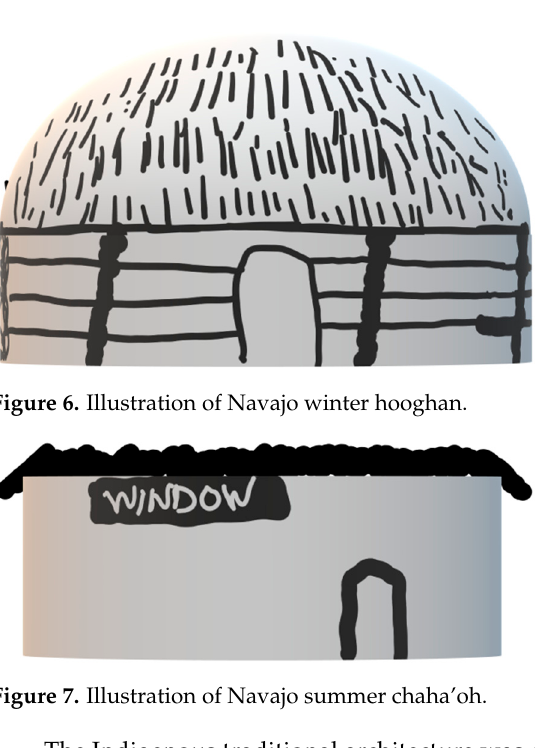
Figure 5. Illustration of Salish plank house.